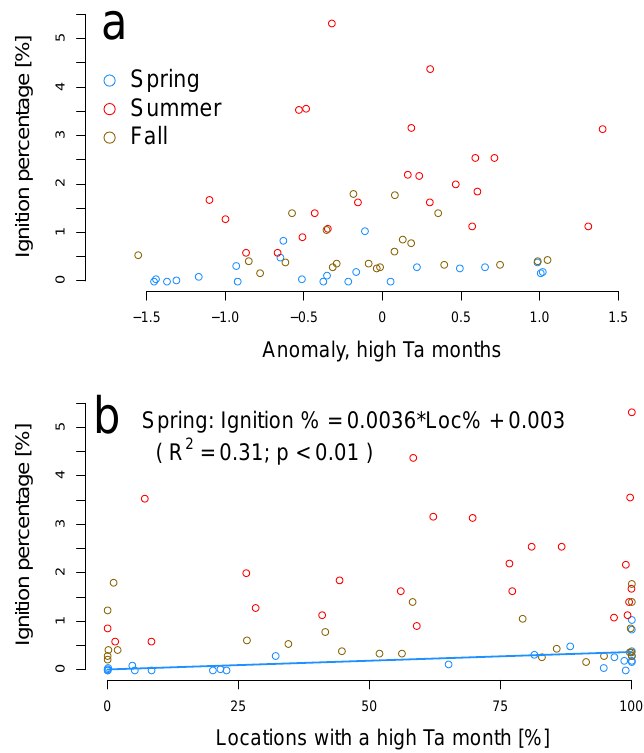
Figure 3. Relationships between the average anomaly of high-air-temperature months (anomaly = observed − long-term mean/standard deviation of long-term mean) and the percentage of locations in the Sierra Nevada region experiencing a wildfire ignition in spring, summer, and fall seasons (Panel a ), and relationships between the percentage of locations in the Sierra Nevada region experiencing a high-air-temperature month and the percentage of locations in the Sierra Nevada region experiencing a wildfire ignition in spring, summer, and fall seasons (Panel b ). Significant relationships are shown in each panel (R 2 coefficient of determination; p <